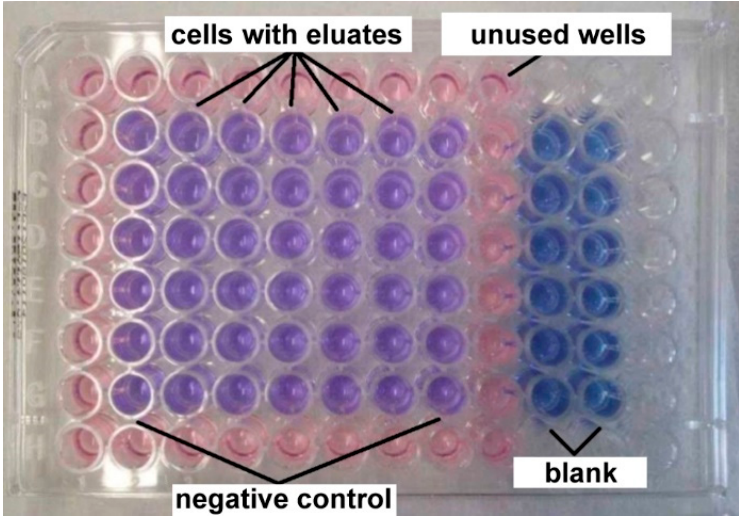
Figure 1. The arrangement of 96-wells plates for cytotoxicity tests.